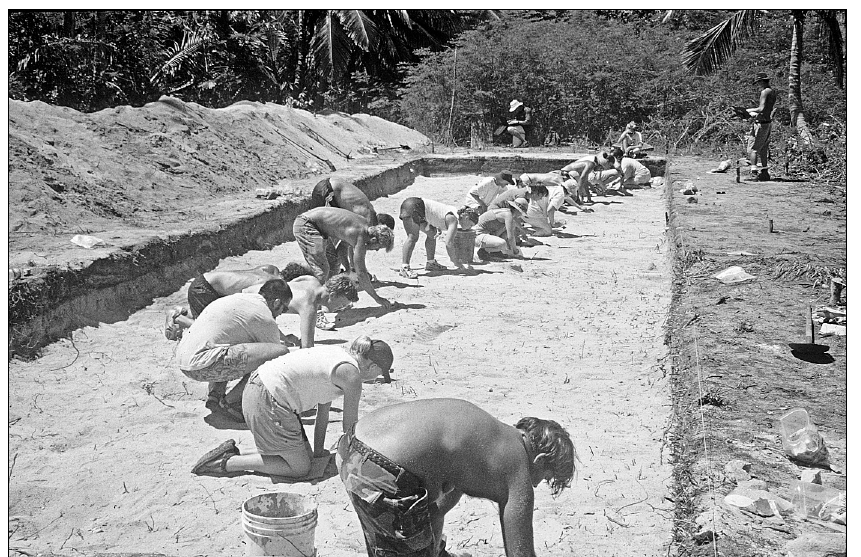
Figure 7 A pot-sherd with a representa- tion of the Sun setting over Belmont Hill, Figure 8 Institute of Archaeology and Longwood University (Virginia, USA ) students c. AD 1000. excavating in the ball court at Belmont, July 1999.